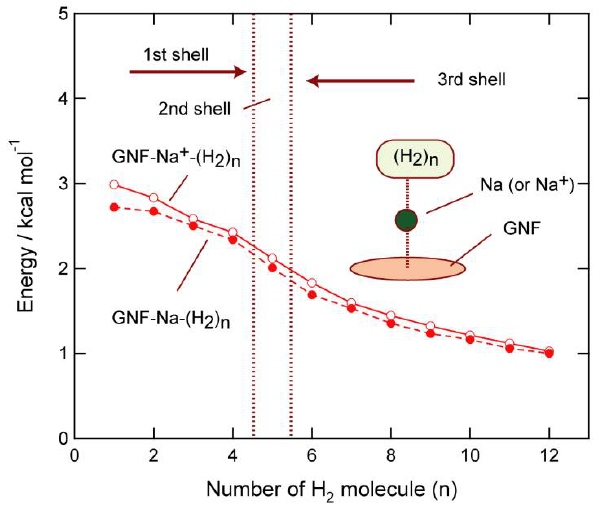
Figure 5. The binding energies of H 2 to GNF(37)–Na and GNF(37)–Na + (per H 2 molecule) plotted as a function of the number of hydrogen molecules ( n ). Calculations were performed at the CAM-B3LYP/6-311G(d,p) level.